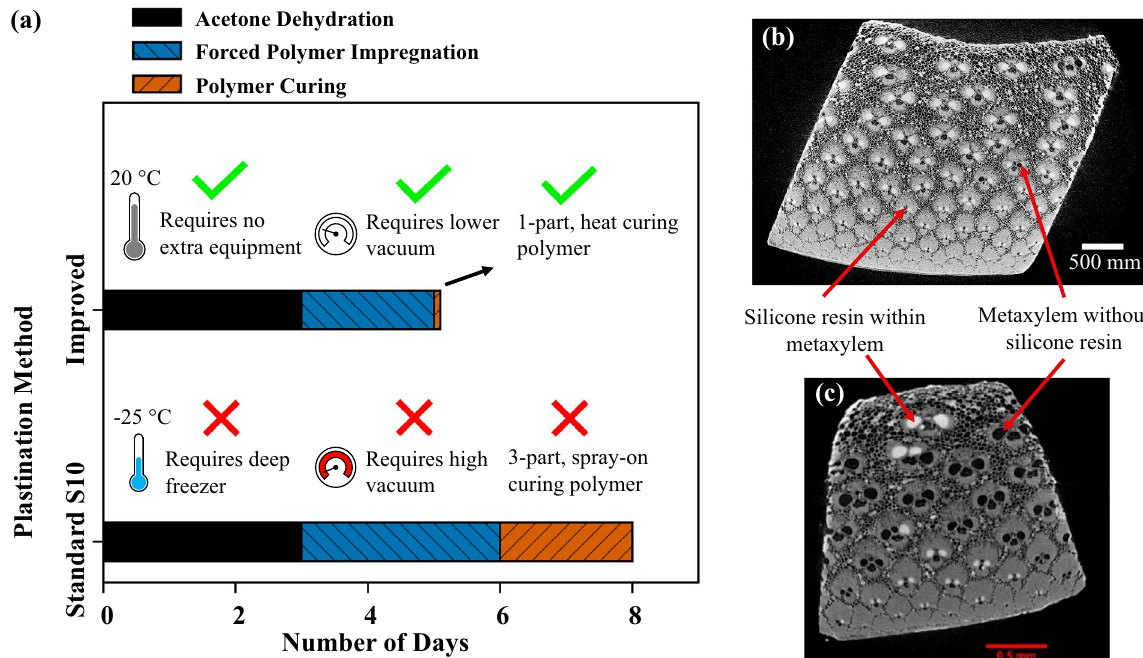
Figure 4. ( a ) Comparison between the processing time taken to plastinate bamboo using the standard S10 and the improved methods. A Micro-CT 2D image slice comparison between the number of metaxylem vessels filled at the centre of a bamboo specimen plastinated using the ( b ) improved and ( c ) standard S10 method 7